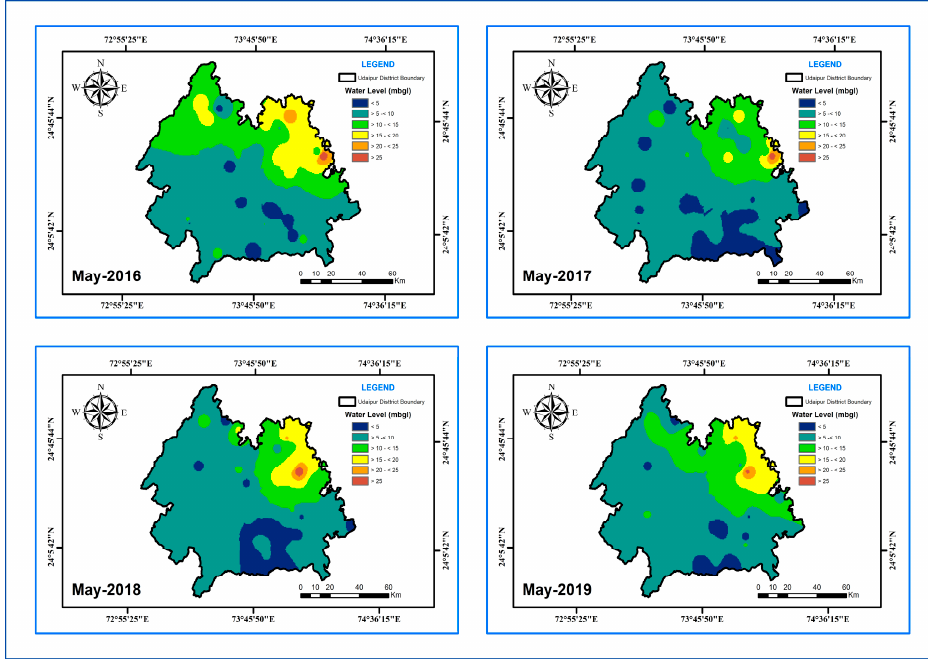
Figure 9. The water-level distribution during pre-monsoon season in the Udaipur district.